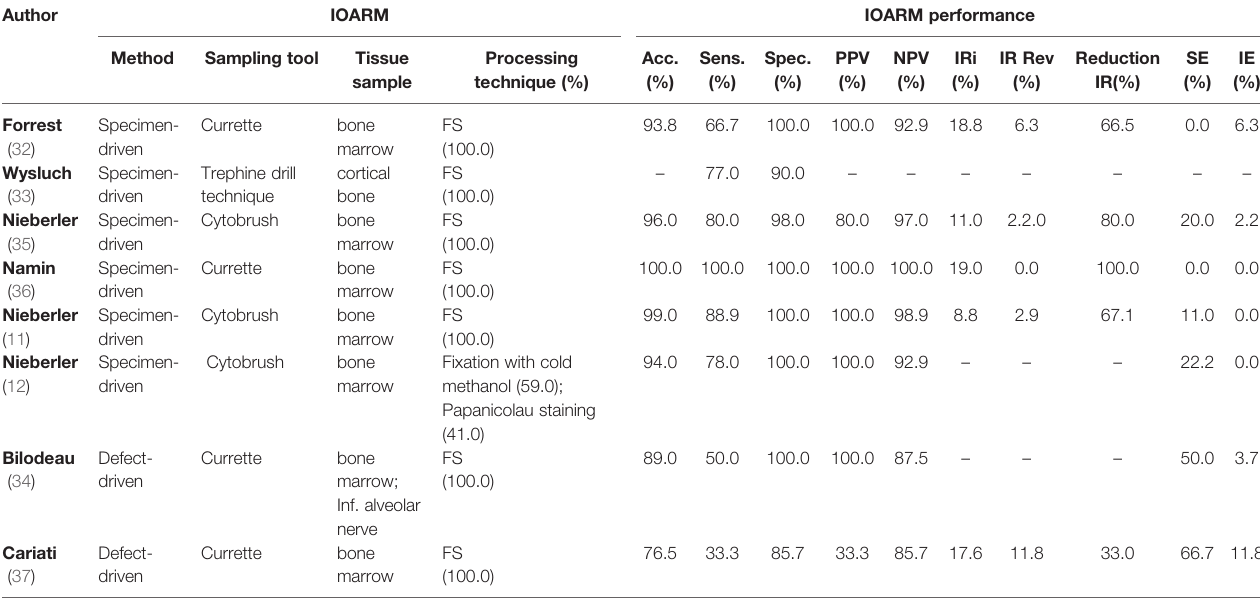
TABLE 5 | IOARM methods in bone tissue: description and performance.